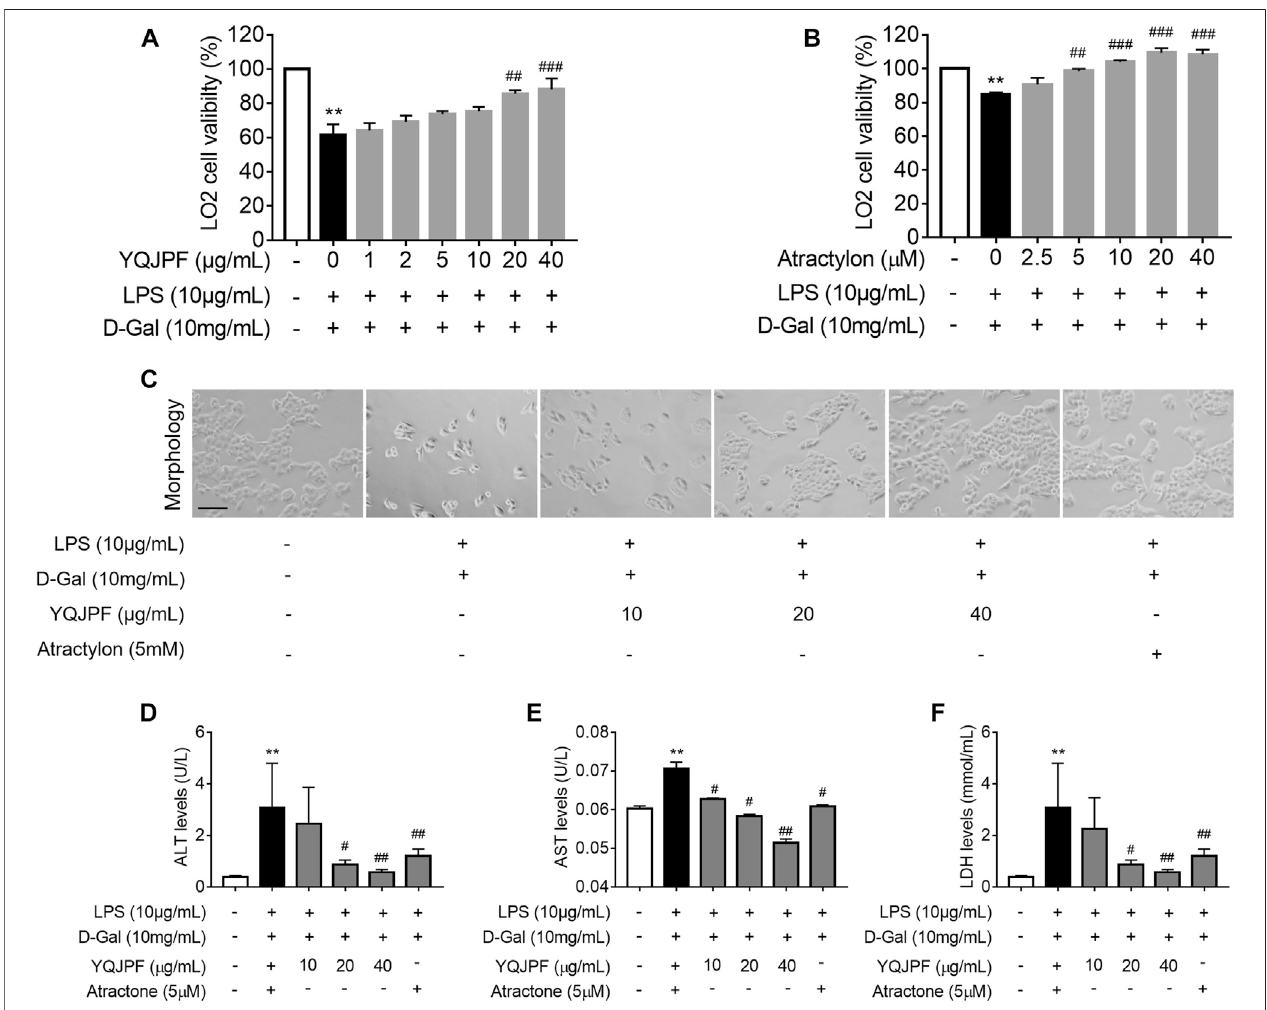
FIGURE4| ProtectiveeffectofYQJPFonLPS-and D-Gal-treated hepatocytes invitro .Human LO2cellsweretreatedwithLPS+D-Galfor4 handfurthertreated with YQJPF and atractylone at indicated concentrations. (A,B) MTT assay to study LO2 cell viability. (C) Cell morphology assessment. Scale bar, 200 μ m. (D – F) ALT, AST,andLDHlevelsinLO2cellculture.Dataareexpressedasmean ± SD( n (cid:2) 6).*vs.controlgroup, # vs.LPS+D-Galgroup;* p < 0.05,** p < 0.01; # p < 0.05, ## p < 0.01.